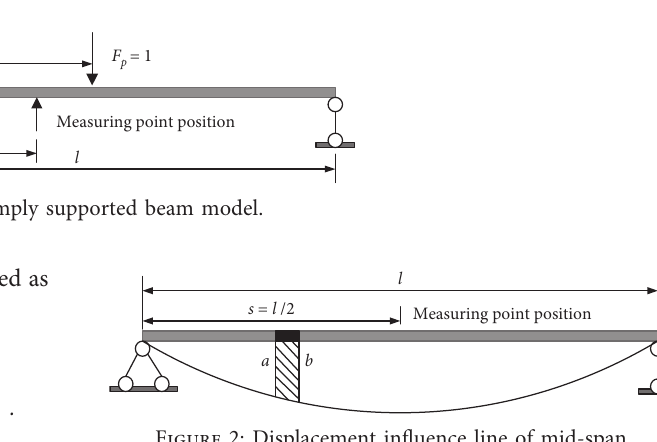
Figure 2: Displacement influence line of